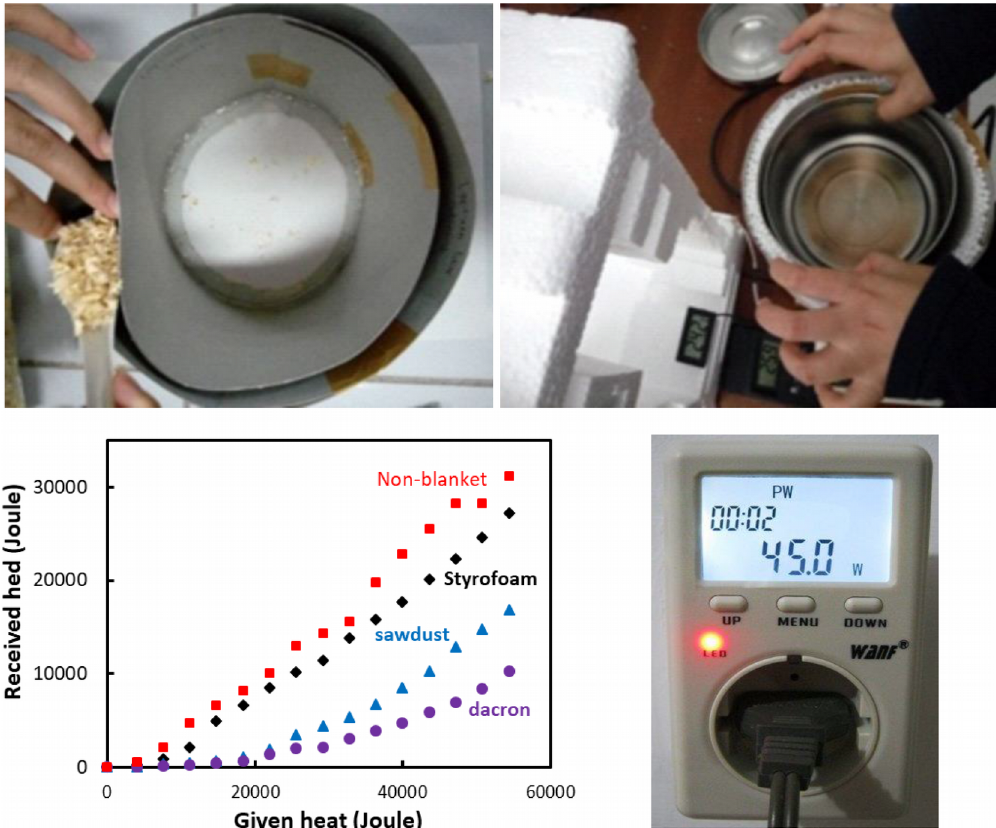
Figure 12. Experiment design for investigating the effect of thermal